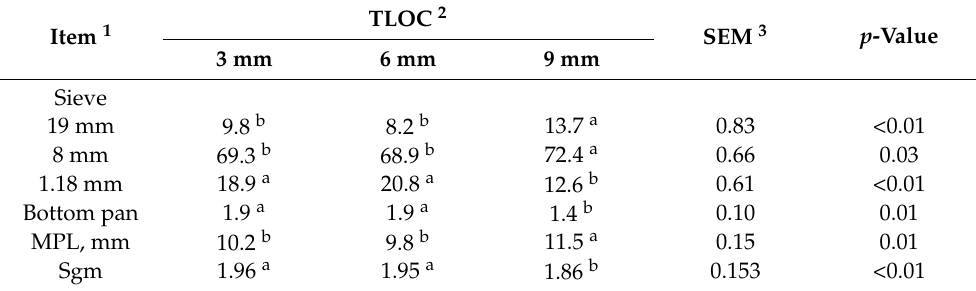
Table 2. Effect of theoretical length of cut on particle size distribution and mean particle length in whole-plant corn silage harvested with a pull-type forage harvester.